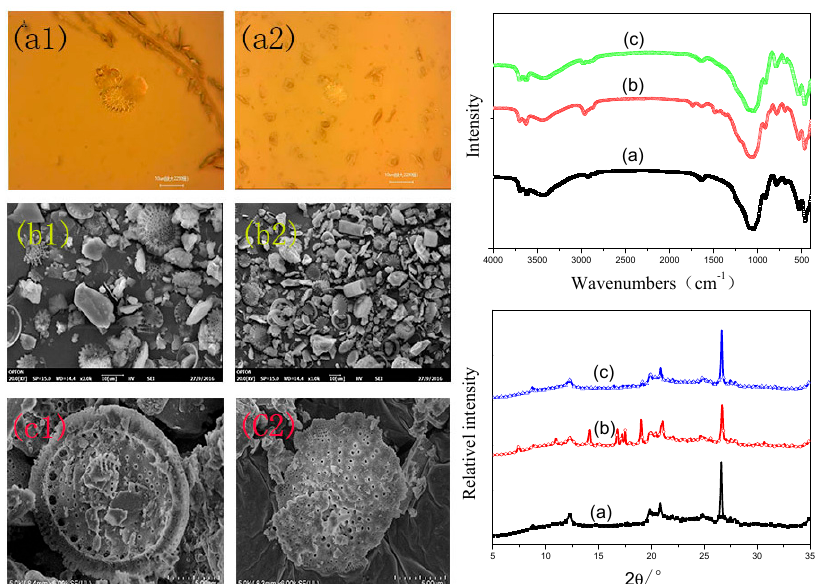
Figure 2. PLM, SEM, FTIR, and XRD of different diatomites: ( a ) original DT; ( b ) KH560-DT; and ( c ) MDT.